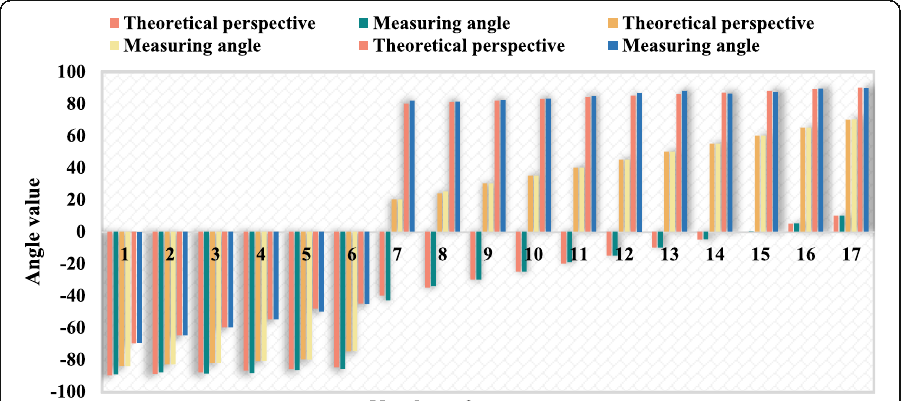
Fig. 6 Average value of pitch angle